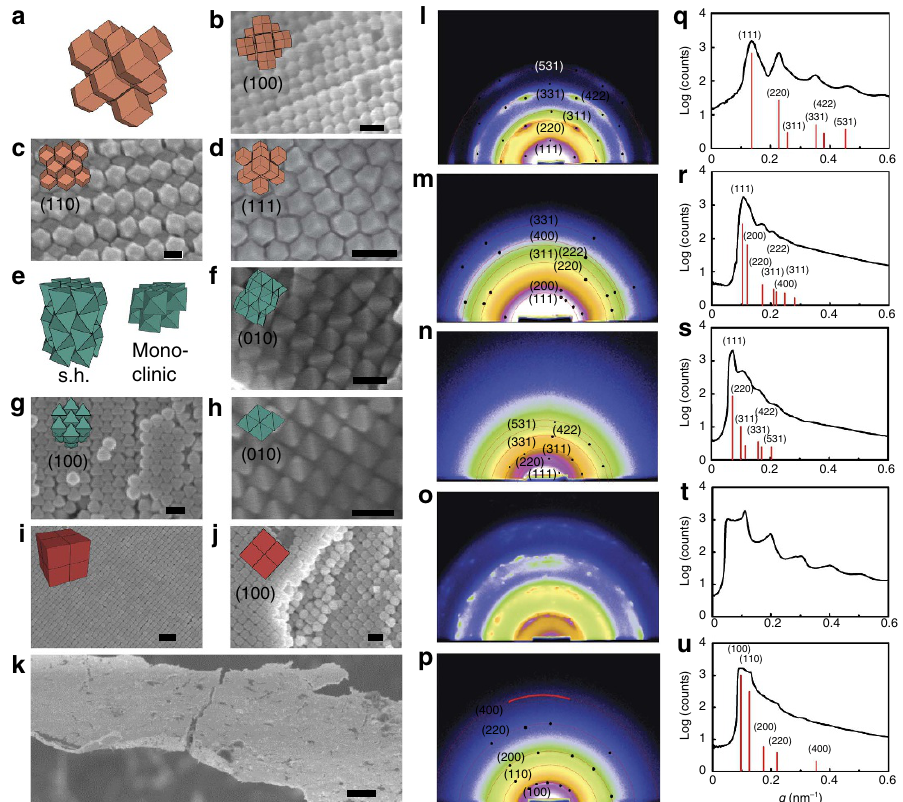
Figure 2 | Analysis of nanocrystal superlattices in using SEM and using SAXS. ( a – d ) Rhombic dodecahedra form a face-centered cubic superlattice visible along different projection directions. ( e – h ) Octahedra are found predominantly in two crystallographically distinct superlattices: simple hexagonal, s.h., ( e – g ) and monoclinic ( e , h ). ( i , j ) Cubes assemble into a simple cubic lattice. ( k ) A macroscopic view shows a complete superlattice film. ( l – p ) Two- dimensional and ( q – u ) radially averaged SAXS images of assembly products exhibit clear diffraction spots and peaks, respectively, highlighting long-range order in superlattices of sRD ( l , q ), mRD ( m , r ), lRD ( n , s ), octahedra ( o , t ) and cubes ( p , u ). For ( l – p ) the data are shown in data on a logarithmic intensity scale and for ( q – u ), the vertical axes represent the logarithmic intensity. Peaks are not indexed for the octahedron superlattice ( o , t ), because the crystal structure is not unique. See Supplementary Movie 1 for more information. Scale bars, ( i ) 200nm; ( k ) 10 m m; all others are